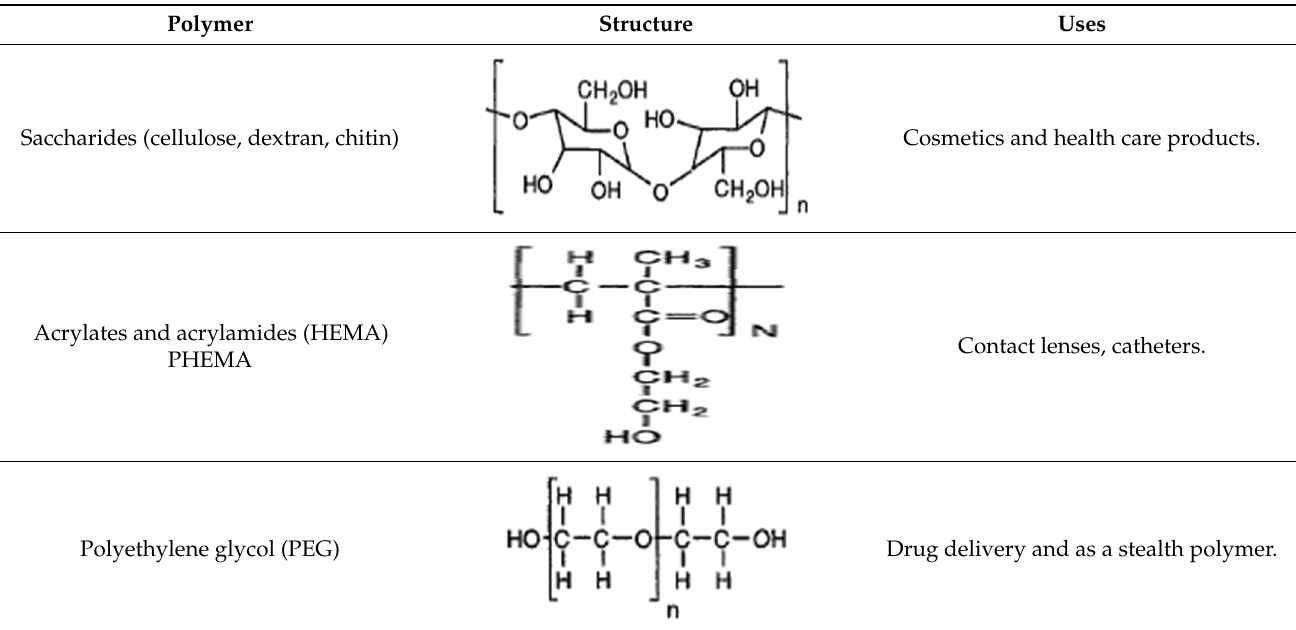
Table 2. Water-soluble polymers [110].